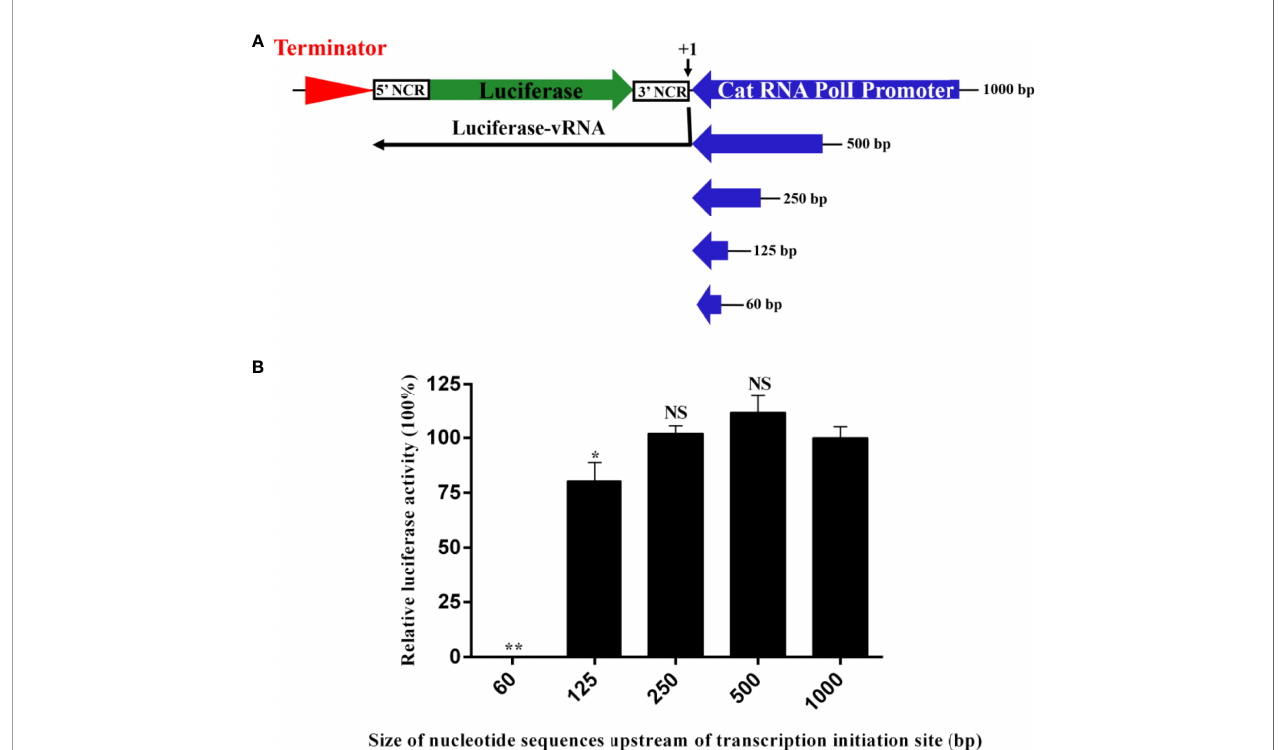
FIGURE 2 | Identi fi cation of the narrowest promoter size required for the highest transcriptional activity of the feline RNA PolI promoter. (A) The strategy for generating arti fi cial vRNA-luciferase reporter transcripts under the control of feline PolI promoters of different lengths. The antisense fi re fl y luciferase coding sequence was fl anked by the 5 ′ and 3 ′ noncoding sequences of the NP segment of in fl uenza virus. Five constructs with cat PolI promoters of different lengths (60, 125, 250, 500, and 1000 bp) were established. (B) Identi fi cation of the narrowest promoter size required for the highest transcriptional activity of the cat RNA PolI promoter using a dual-luciferase reporter assay. pCAT60, pCAT125, pCAT250, pCAT500, and pCAT1000 (300 ng) were each individually combined with expression plasmids expressing PB1 (200 ng), PB2 (200 ng), PA (200 ng), and NP (300 ng) proteins of WSN/33 (pCAGGs-WSN-PB1, pCAGGs-WSN-PB2, pCAGGs-WSN-PA, and pCAGGs-WSN-NP, respectively). Together with pRL-TK (30 ng), these plasmids were transfected into CRFK cells in a 24-well plate using FuGENE transfection reagent (Promega, USA) according to the manufacturer ’ s instructions. At 24 h after transfection, dual luciferase activity was detected (Promega, USA), and the relative luciferase activity was represented as the ratio of fi re fl y luciferase to Renilla luciferase. The relative luciferase activity subjected to the pCAT1000 construct was set as 100%. The results of three repeated experiments are shown. The differences in RNA PolI activity were compared with the pCAT1000 experimental group using an unpaired two-tailed Student ’ s t test (NS, not signi fi cant; * p < 0.05; ** p <